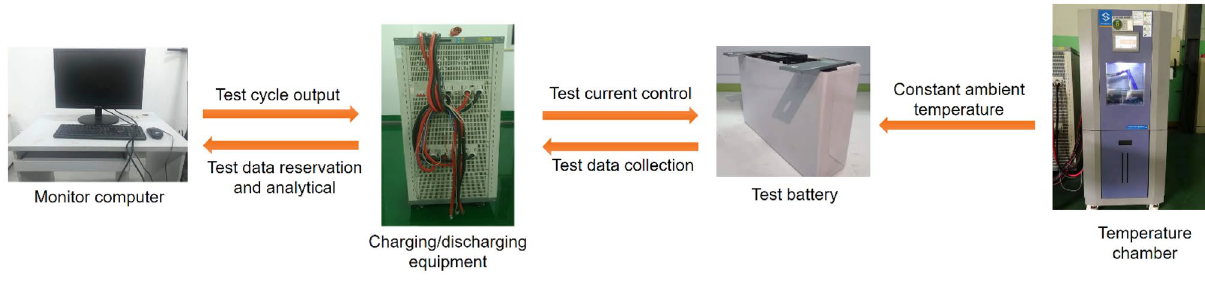
Figure 5. Workbench design.